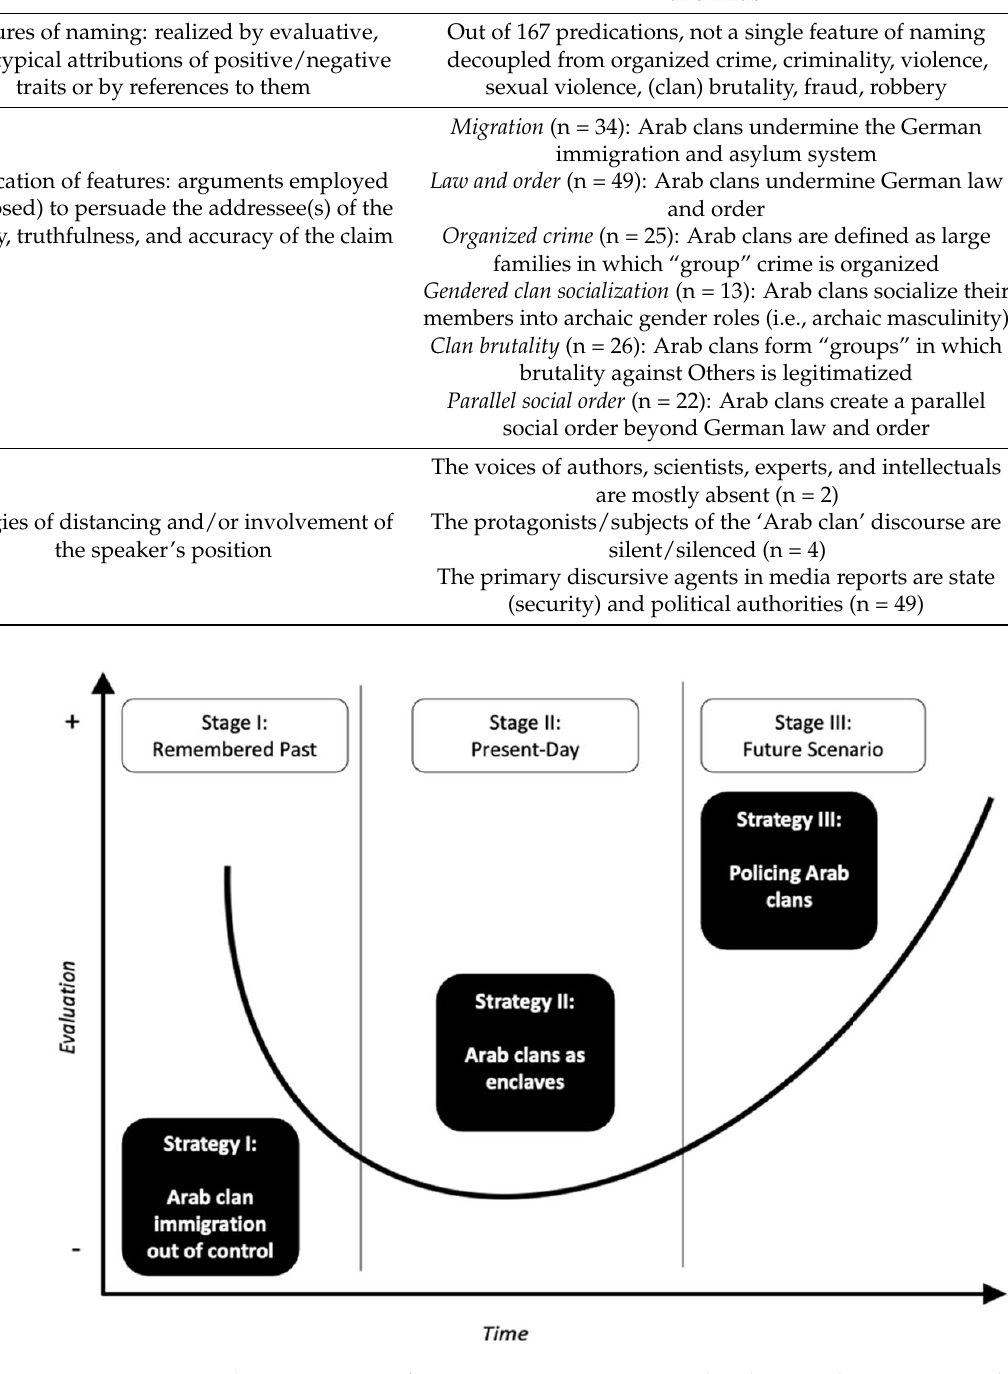
Figure 3. Integrated representation of argumentative strategies used in the comedy-romance emplotment of German media discourse about ‘Arab clans’ (2010– 2019).